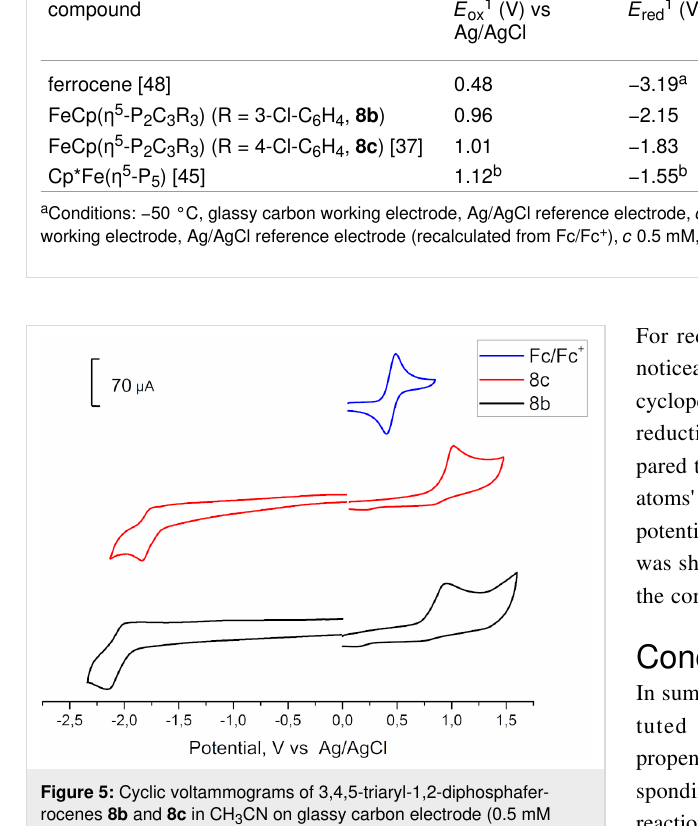
Table 1: Electrochemical data for the redox properties of 3,4,5-triaryl-1,2-diphosphaferrocenes 8b and 8c . compound E ox1 (V) vs Ag/AgCl